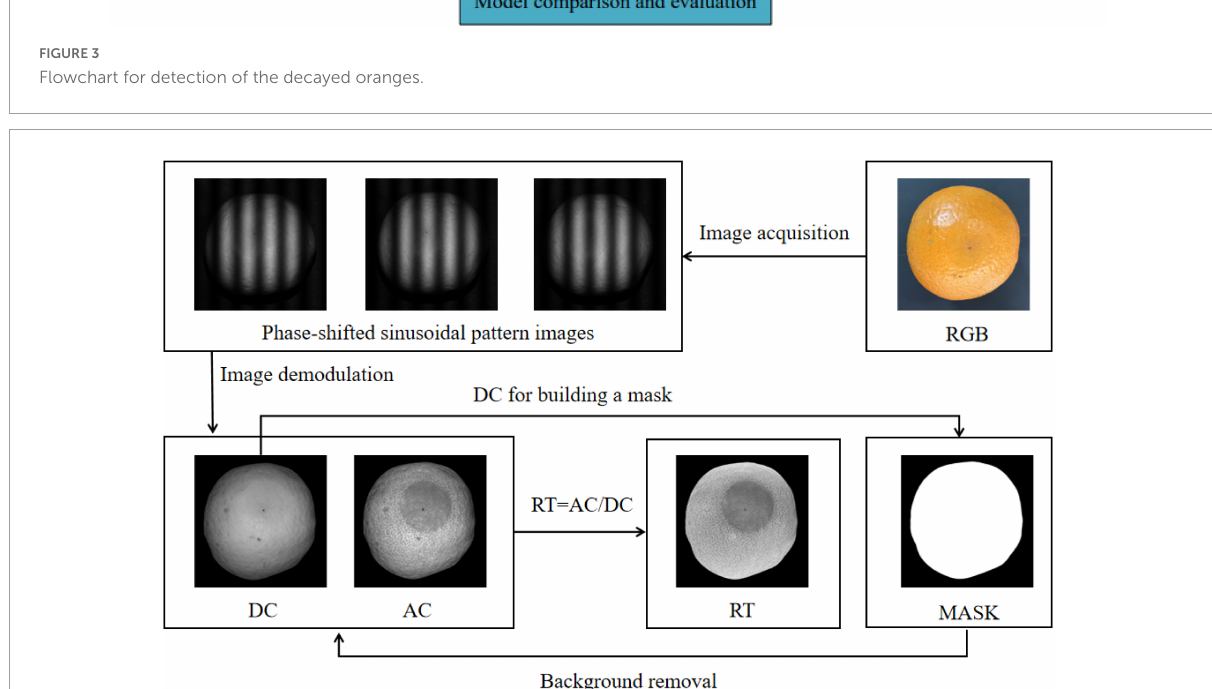
can be used for effective detection of decay on oranges. In fact, the AC image represents the image containing the specific depth tissue information matched with the used structured light frequency. In this study, although black background was used in